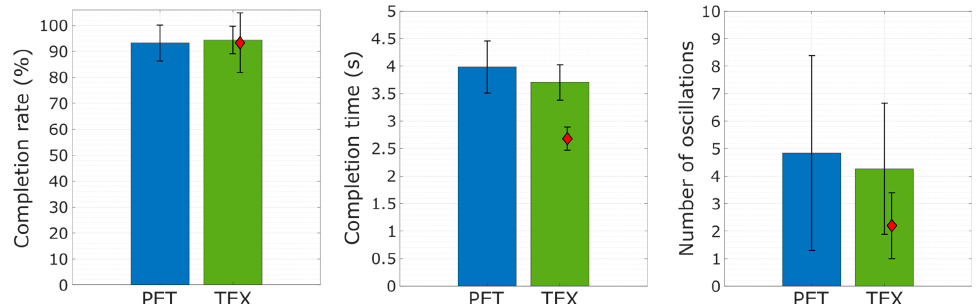
Figure 13. The outcome measures for the online gesture-matching task. The bars represent the mean and standard deviation for the completion rate, completion time and the number of oscillations obtained in able-bodied participants. The results for the amputee subject are denoted with a diamond.